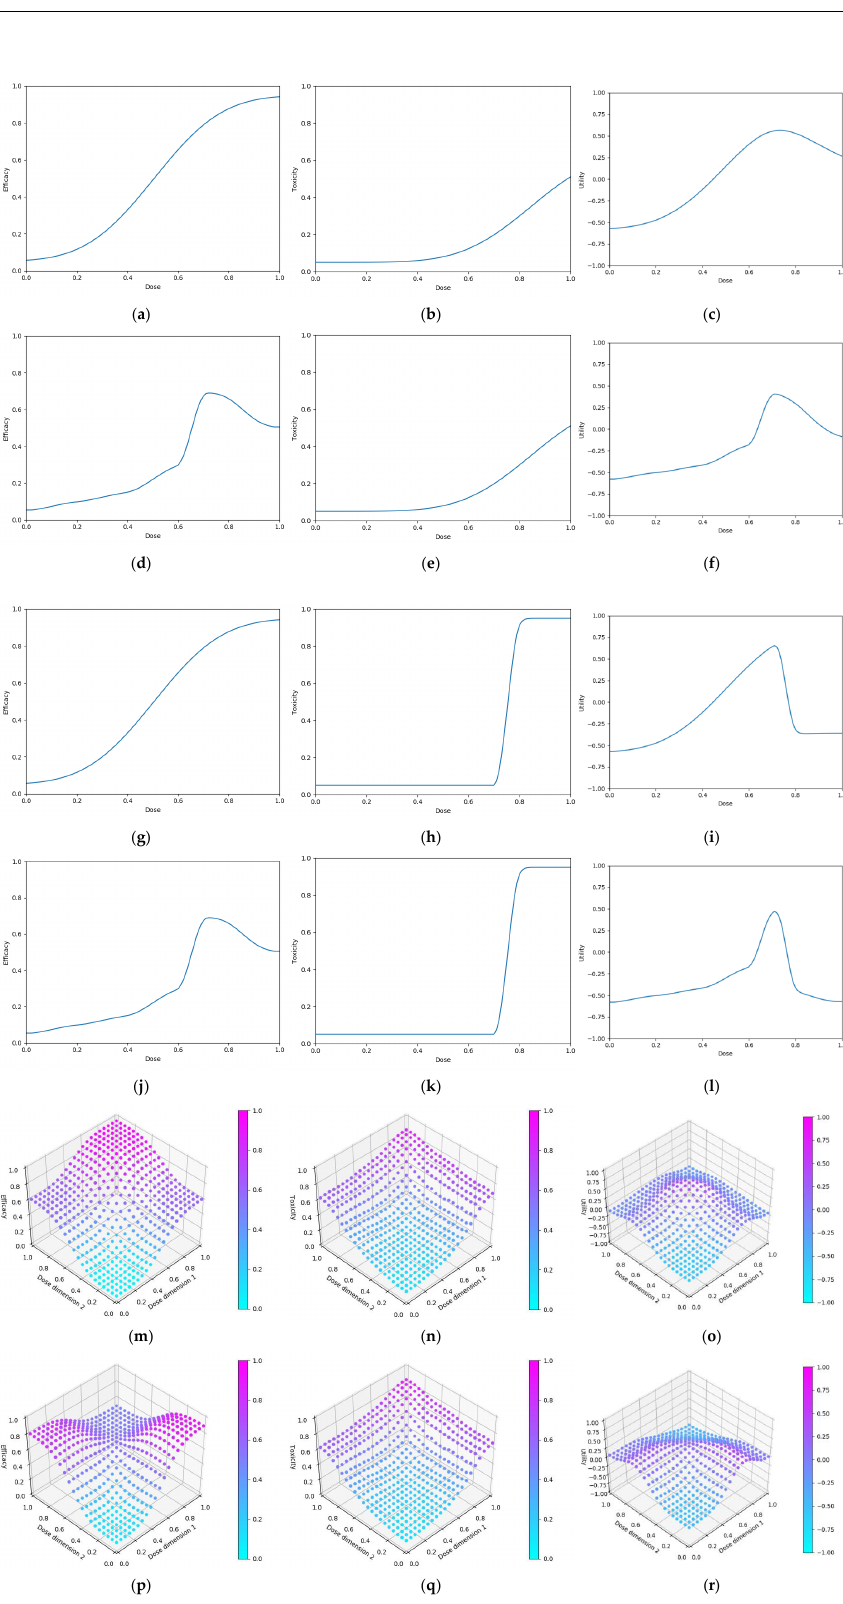
Utility function: Utility Contour • Efficacy curve: Is defined for each scenario • Toxicity curve: Is defined for each scenario Six scenarios were used in this objective (Figure 8). The single-administration scenar- ios reflect cases for which vaccines 19. have gradually increasing efficacy and toxicity with dose (Figure 8a – c) 20. have sharply peaking efficacy and gradually increasing toxicity with dose (Figure 8